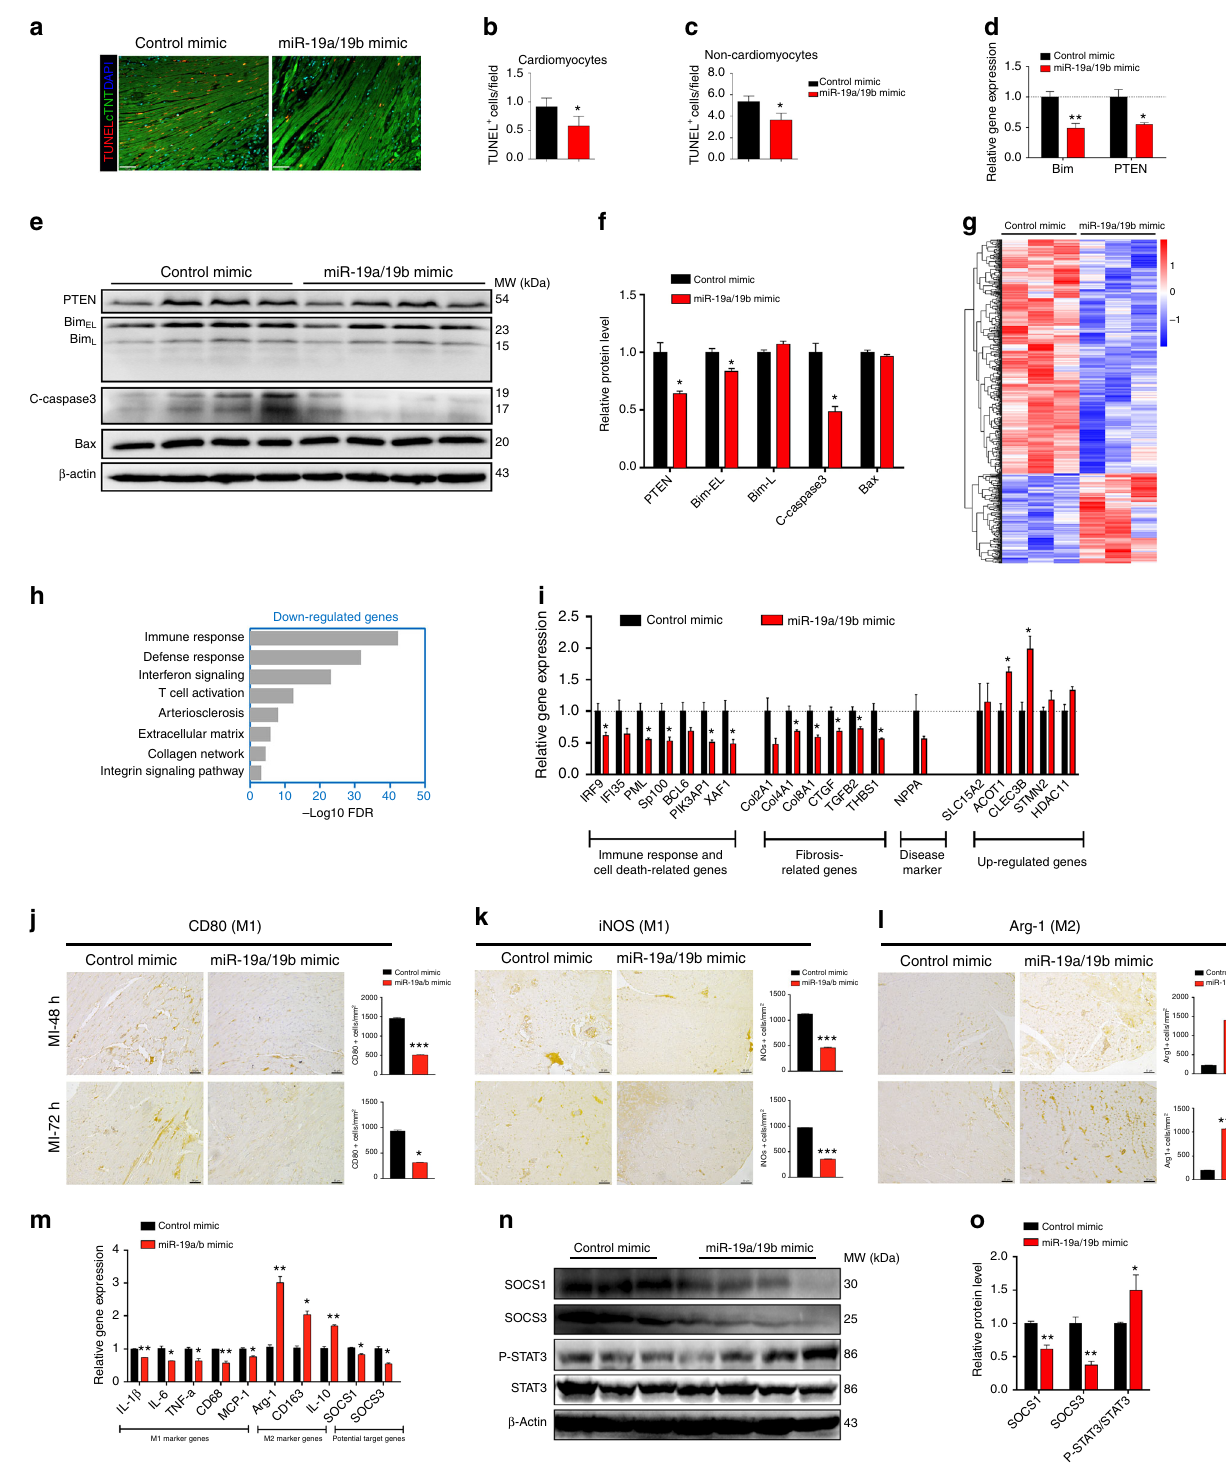
expression of SOCS1 and phosphorated STAT3 and found decreased expression of SOCS1 and increased levels of phos- phorated STAT3 24 h after tail vein injection of miR-19a/19b (Fig. 7h). To further validate the therapeutic role of miR-19a/19b in cardiac protection, we utilized Lipofectamine RNAiMAX, which was recently shown to mediate miRNA delivery ef fi - ciently 12 , to deliver miR-19a/19b mimics via tail vein injection. NATURE COMMUNICATIONS| (2019) 10:1802